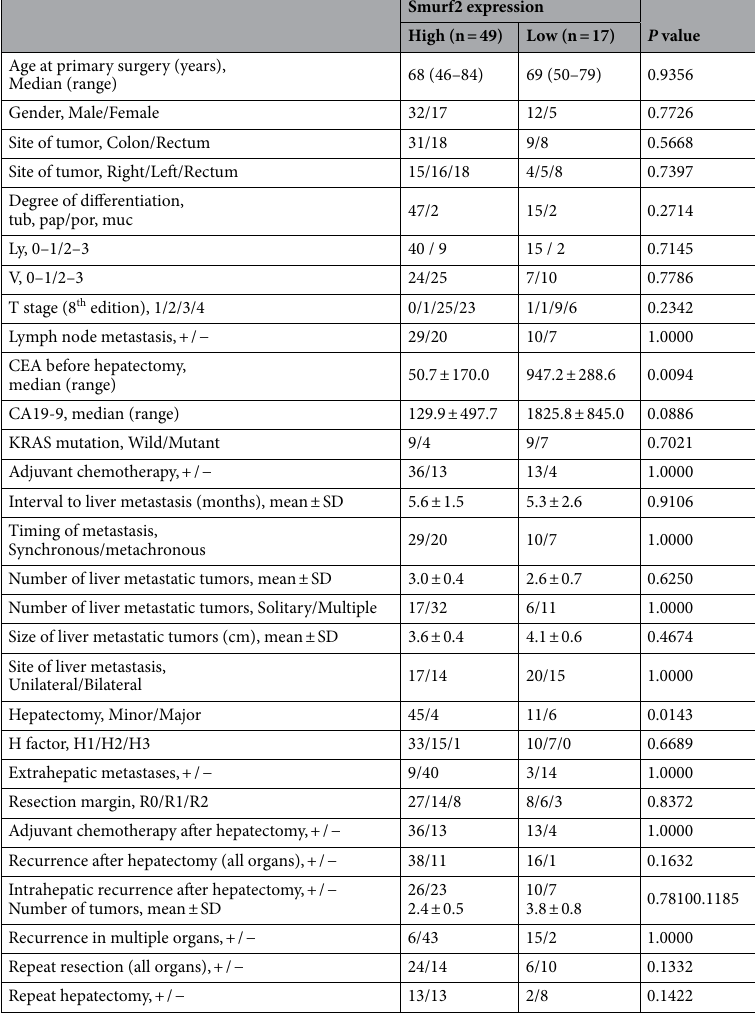
Table 3. Clinicopathologic features of patients diagnosed with colorectal liver metastases showing high and low Smad ubiquitination regulatory factor 2 (Smurf2) expression. CEA, carcinoembryonic antigen; CA19-9, carbohydrate antigen 19–9; KRAS, Kirsten rat sarcoma viral